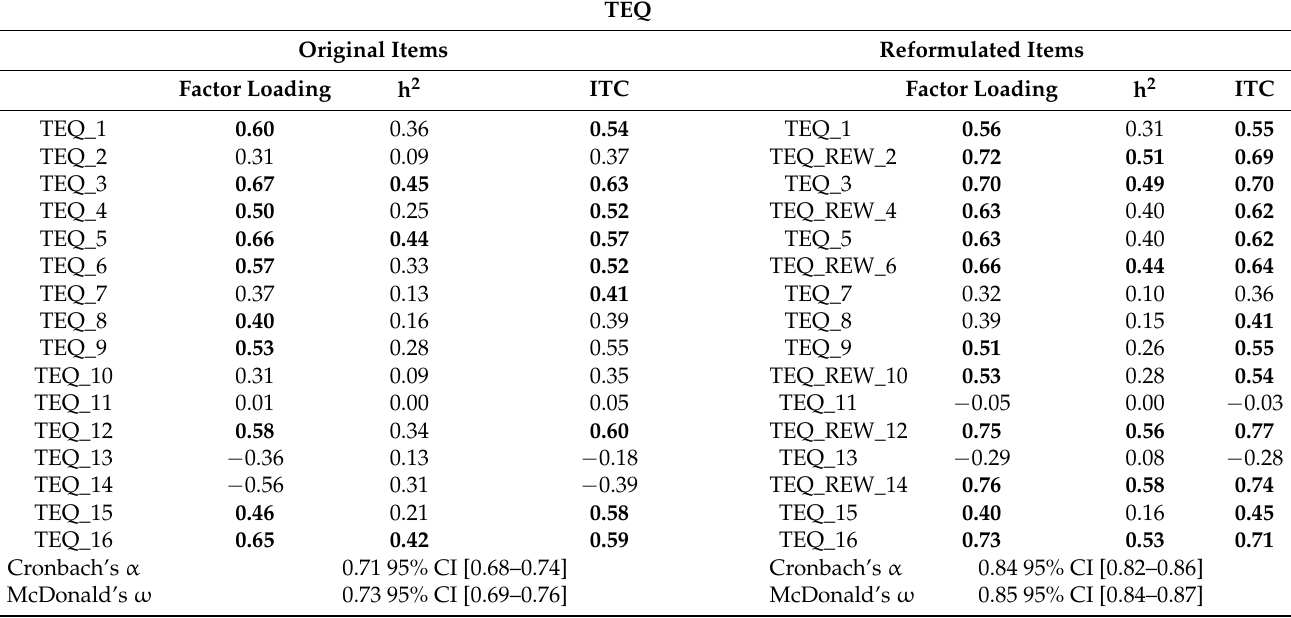
Table 1. Original and reworded item characteristics (Study 1, n =